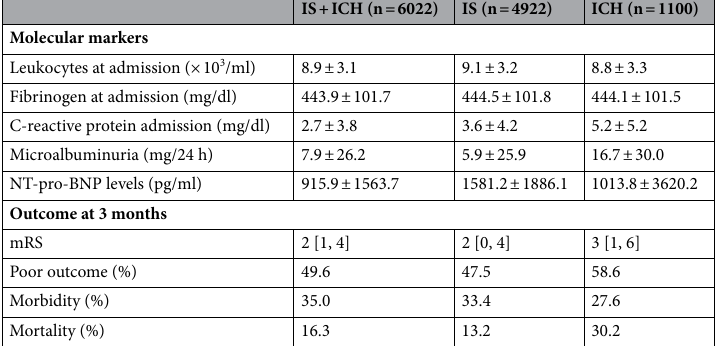
Table 3. Molecular markers and outcome at 3 months of the experimented dataset of patients summarized by group.